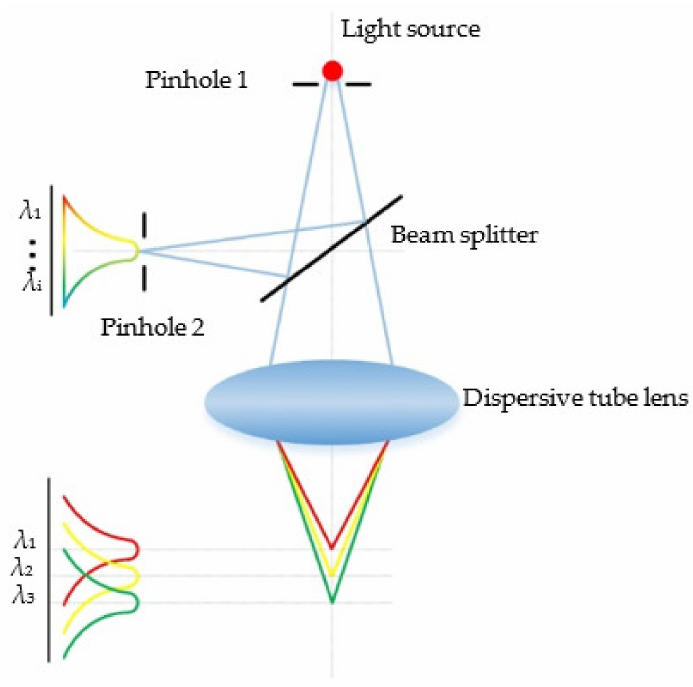
Figure 5. Schematic diagram of the intensity